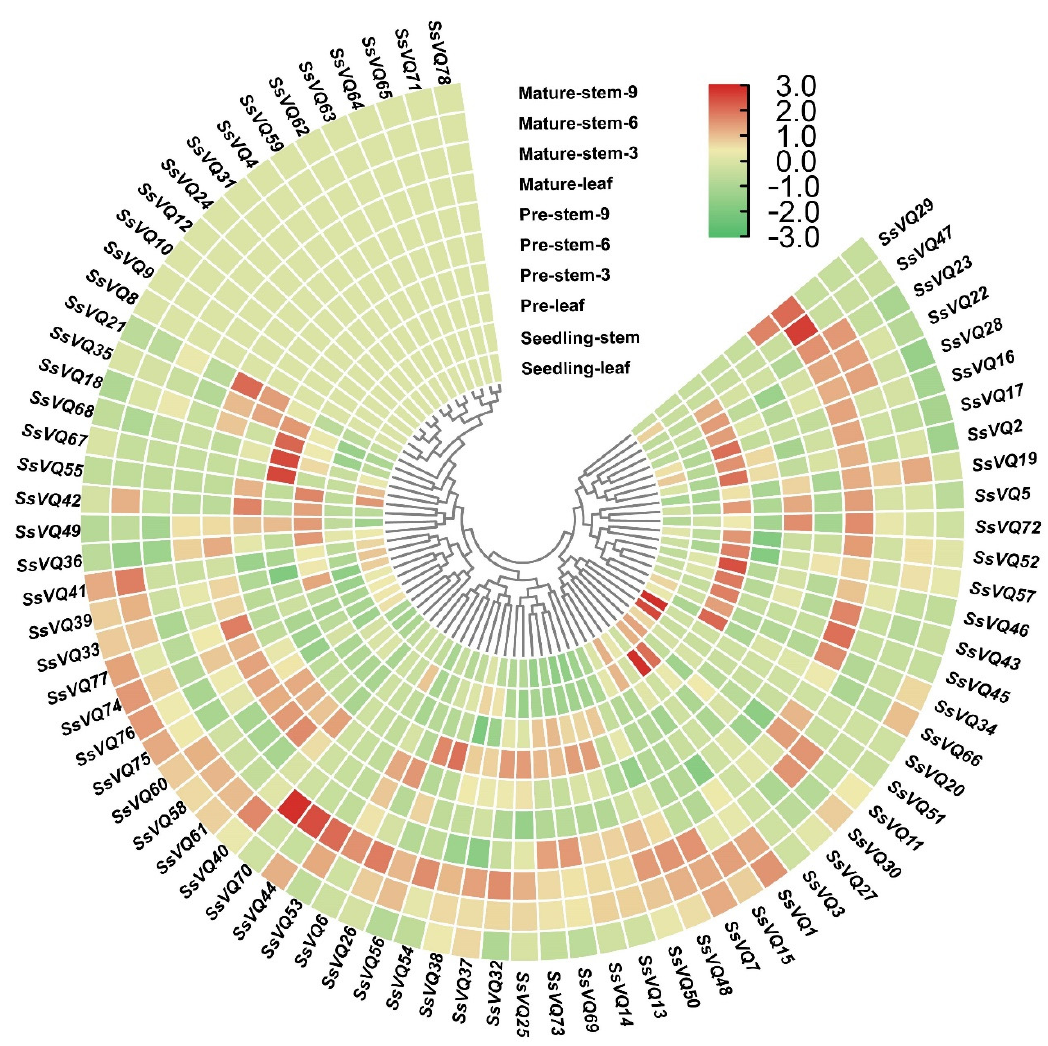
Figure 7. Expression profiles of the VQ genes from Saccharum spontaneum at different stages. The color bar represents the normalized values (log 2 FPKM). The original normalized values are shown in Table S6.